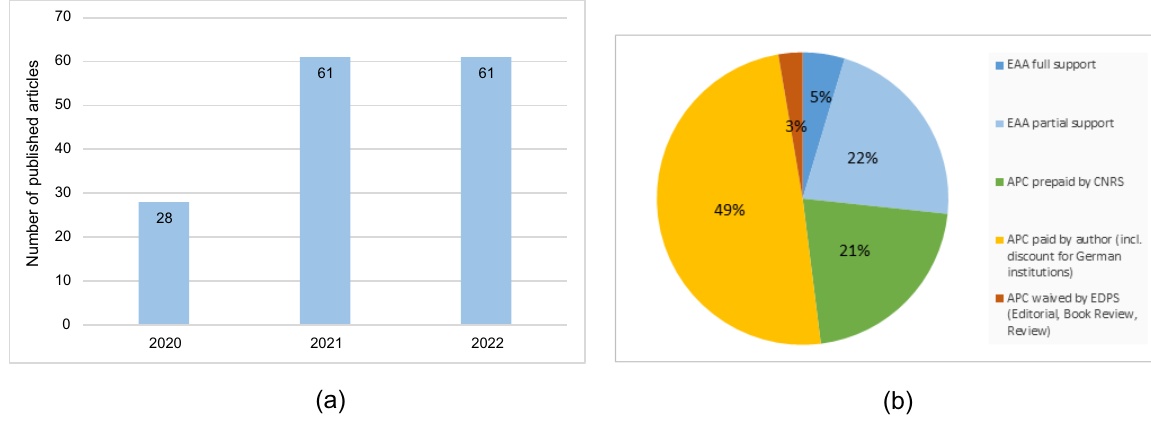
Figure 6. (a) Number of published articles per year and (b) overview of article processing charge (APC).